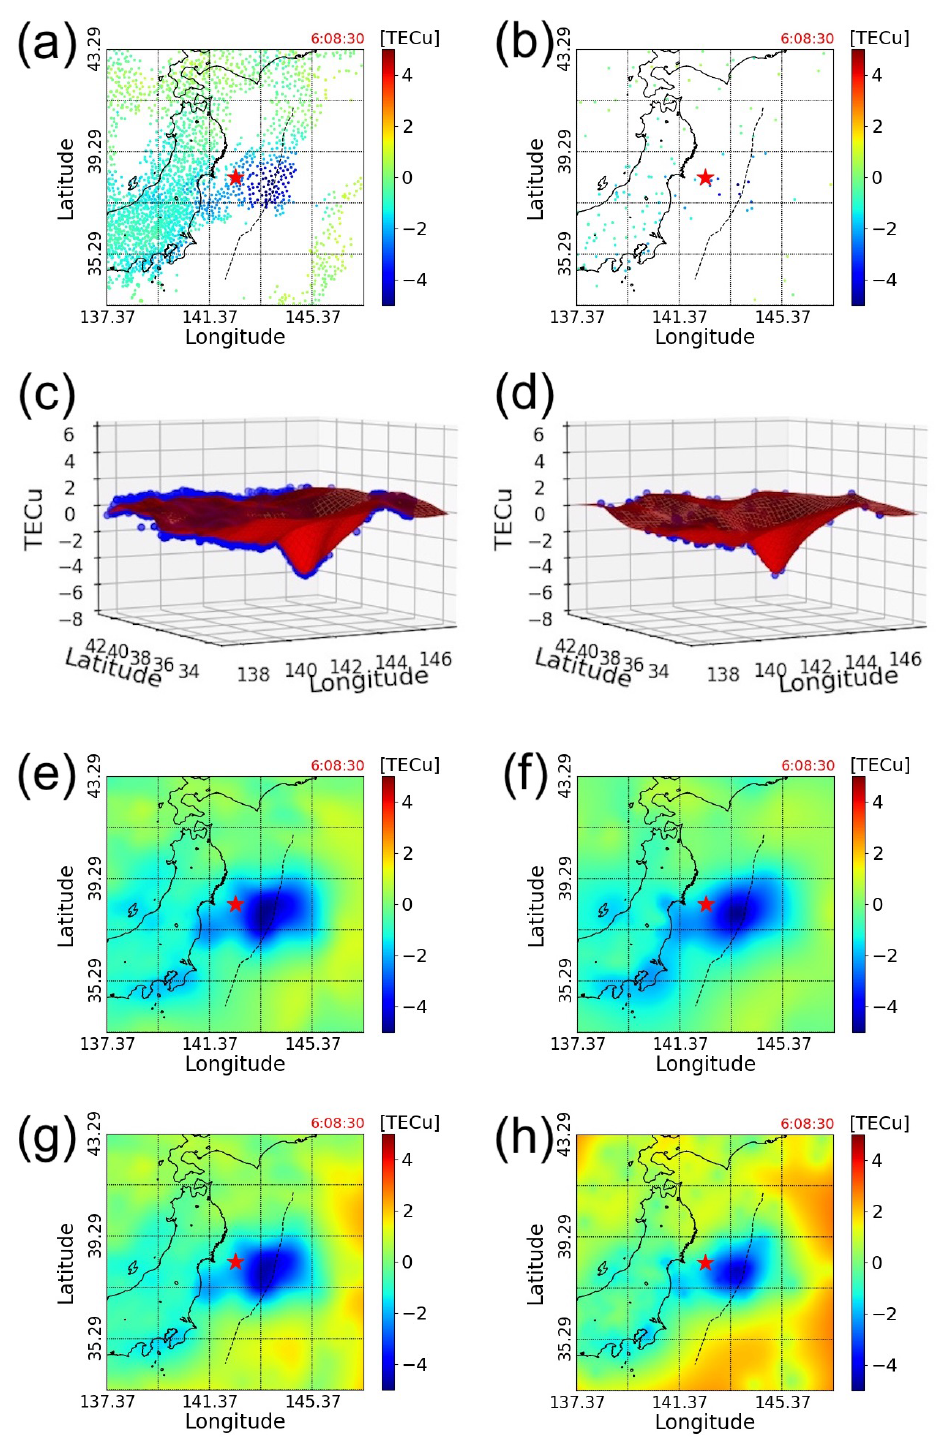
Figure 5. Left-hand side is for the full data; right-hand side is for the sparse data using only 5% of the GEONET receivers. Panels (a) and (b) are measured TEC data. Panels (c) and (d) are measured TEC data (blue dots) and the fitting surface (red surface). Panels (e) and (f) are 2D projections of the fitting surface. Panels (g) and (h) are 2D projections of the 99% one-sided CI of the fitting surface. The fitting surface is computed using the INLA-SPDE method. The black dashed line indicates the location of the axis of the Japan Trench.